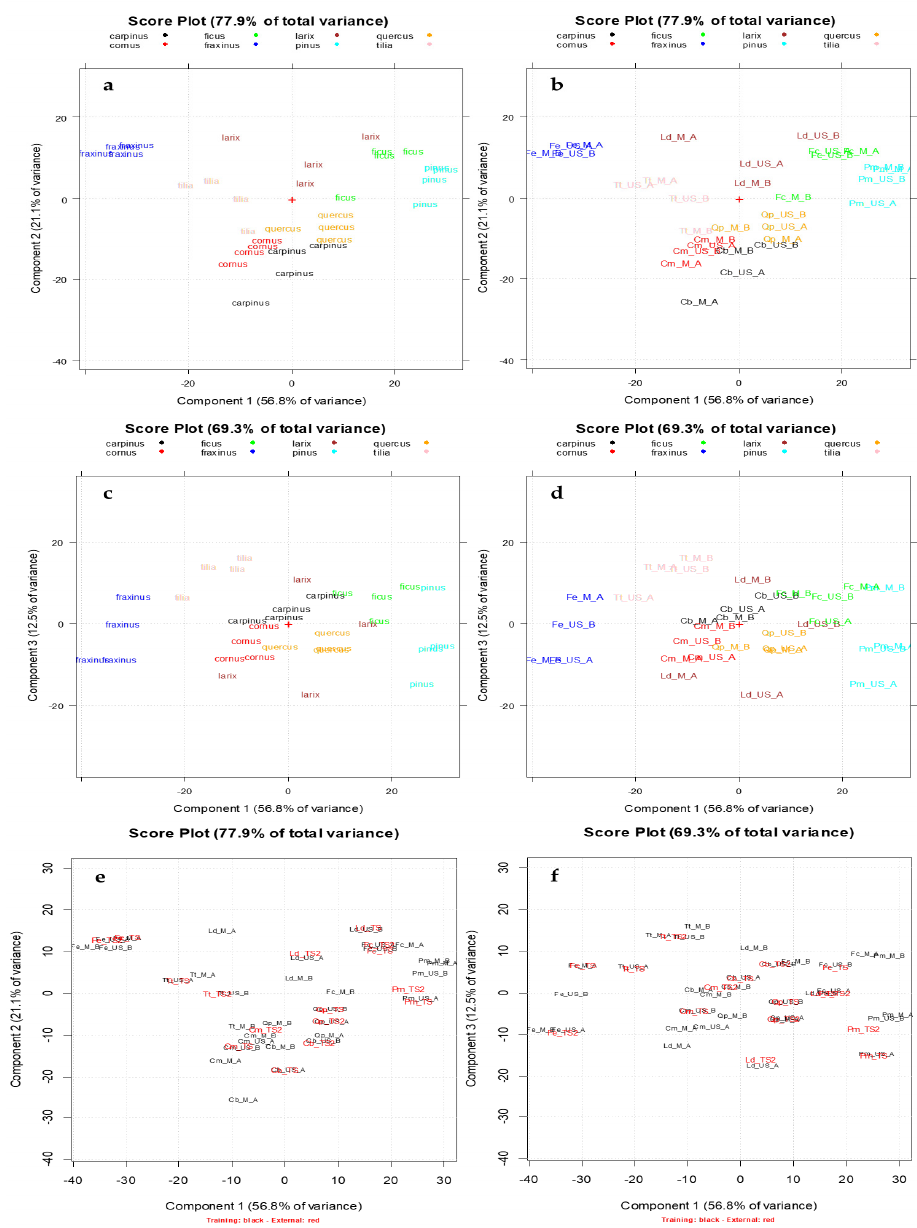
Figure 3. The scores plots of the UV–Visible absorbances data matrix A 32,601 . Each vegetable species is reported with a di ff erent color ( Carpinus betulus L.: black, Cornus mas L.: red, Ficus carica L: green., Fraxinus excelsior L.: blue, Larix decidua Mill.: brown, Pinus montana Mill.: light blue, Quercus petraea (Matt.) Liebl.: orange, Tilia tomentosa Moench: pink). ( a ) PC1-PC2 score plot with BDs categorized according to the vegetable species; ( b ) PC1-PC2 score plot with BDs categorized according to their identification code (Table 2); ( c ) PC1-PC3 score plot with BDs categorized according to the vegetable species; ( d ) PC1-PC3 score plot with BDs categorized according to their identification code (Table 2); ( e ) PC1-PC2 score plot obtained projecting the external test set samples (highlighted in red); ( f ) PC1-PC3 score plot obtained projecting the external test set samples (highlighted in